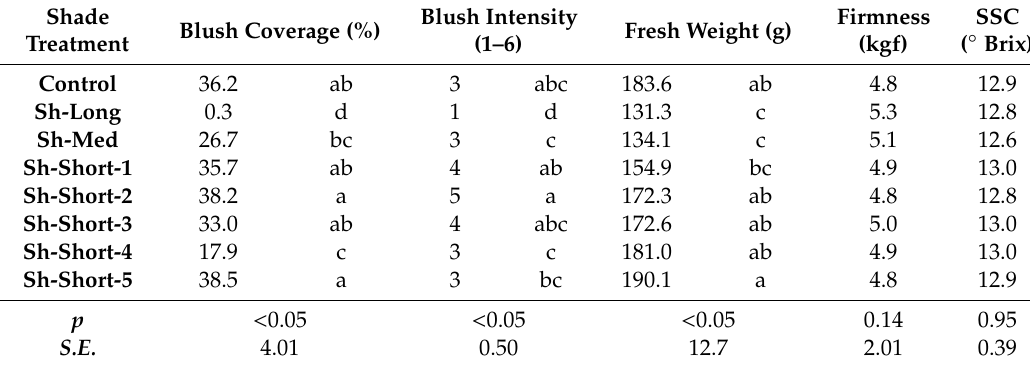
Table 1. Means of harvest fruit quality parameters of all treatments in the “ANP-0118”. Letters indicate means separation by Fisher’s LSD ( α = 0.05). Probability value ( p ) and the standard error of the means ( S.E. ) are